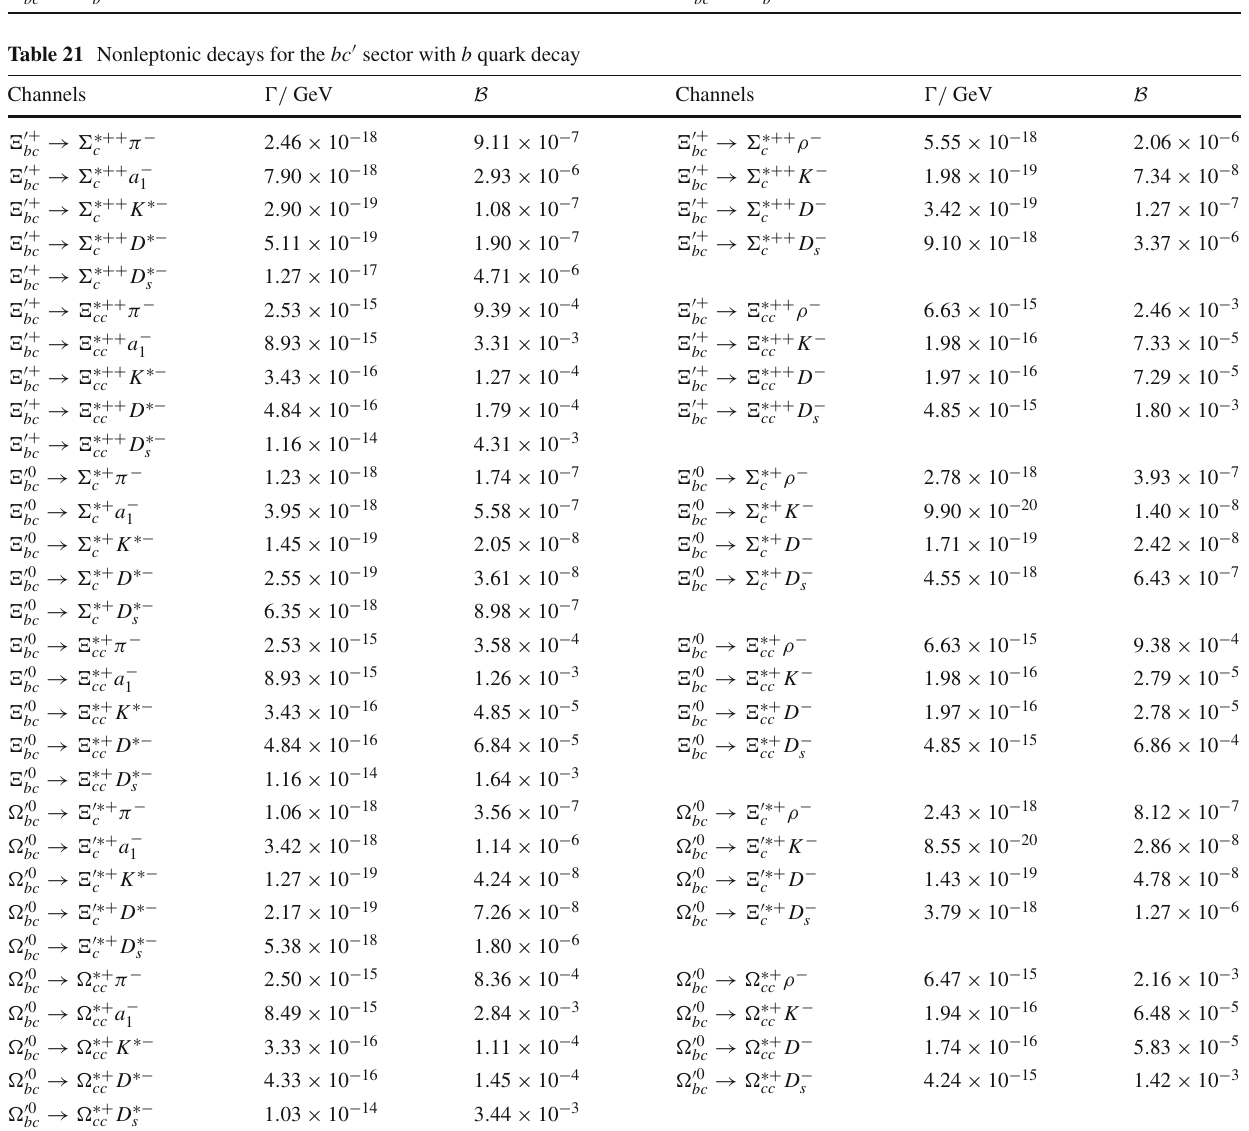
Table 21 Nonleptonic decays for the bc (cid:3) sector with b quark